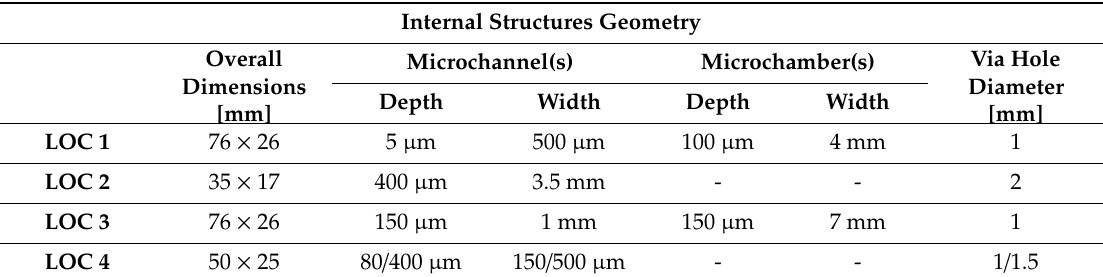
Table 1. Summary of geometrical specification for each lab-on-chip (LOC).